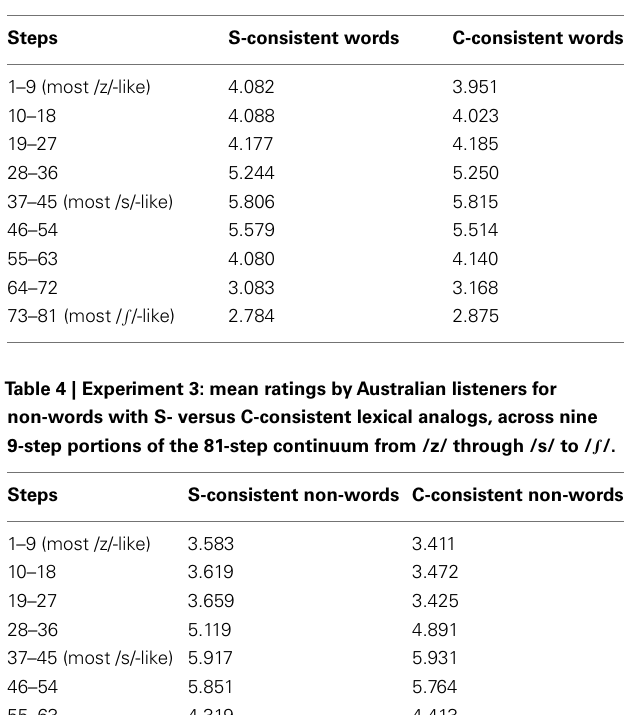
Table 3 | Experiment 2: mean ratings by Dutch listeners for S- versus C-consistent English words across nine 9-step portions of the 81-step continuum from /z/ through /s/ to / ∫ /.